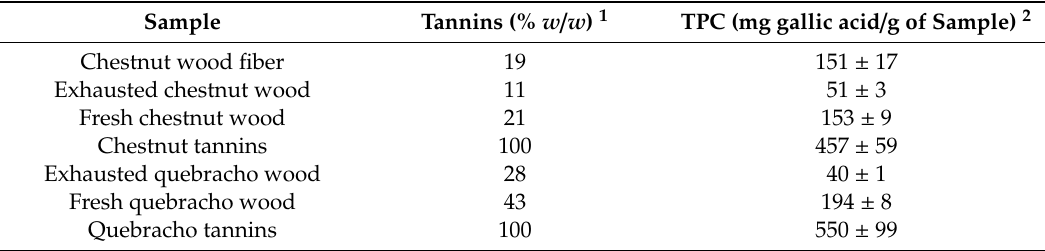
Table 2. Tannin content and total phenolic content (TPC) of wood samples.